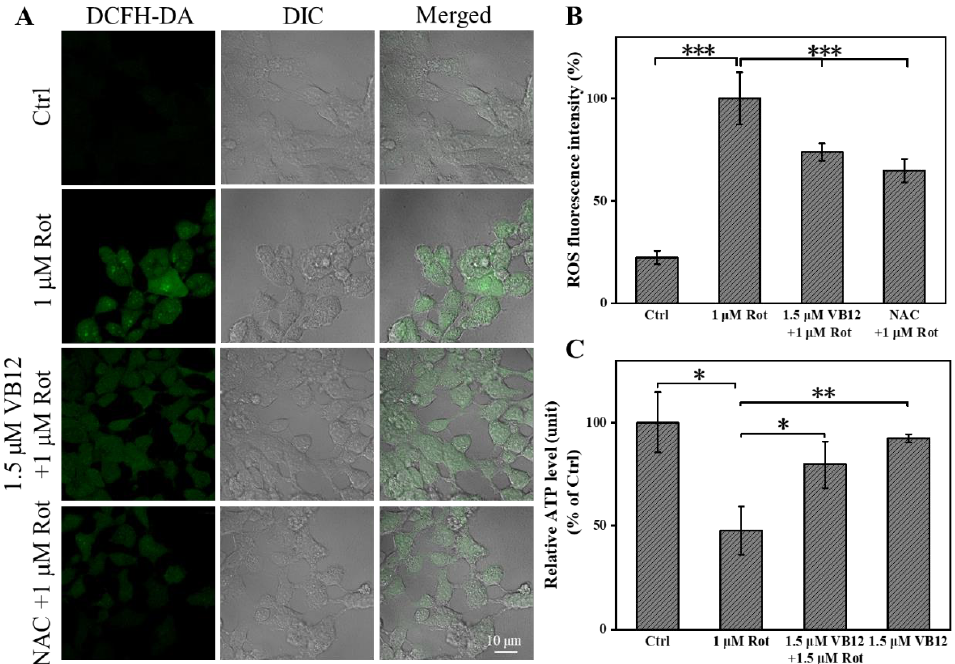
Figure 2. VB12 decreases intracellular ROS and increases ATP content. ( A ) Fluorescence imaging of intracellular ROS treated with Rot, Rot+VB12, or Rot+NAC. ( B ) Fluorescence intensity quantification of (A). ( C ) ATP content analysis of SH- SY5Y cells. Scale bar = 10 μm. Data are the mean ± SEM, n = 3. * p < 0.05, ** p < 0.01, *** p < 0.001. Cells maintain their redox homeostasis by regulating ROS and reductant levels.